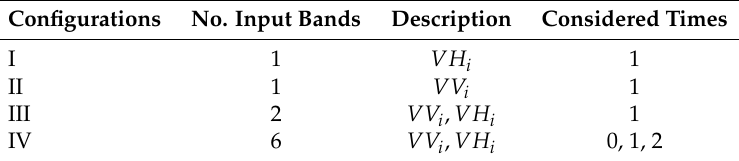
Figure 4. The general workflow. Table 4. Different input stack considered in training